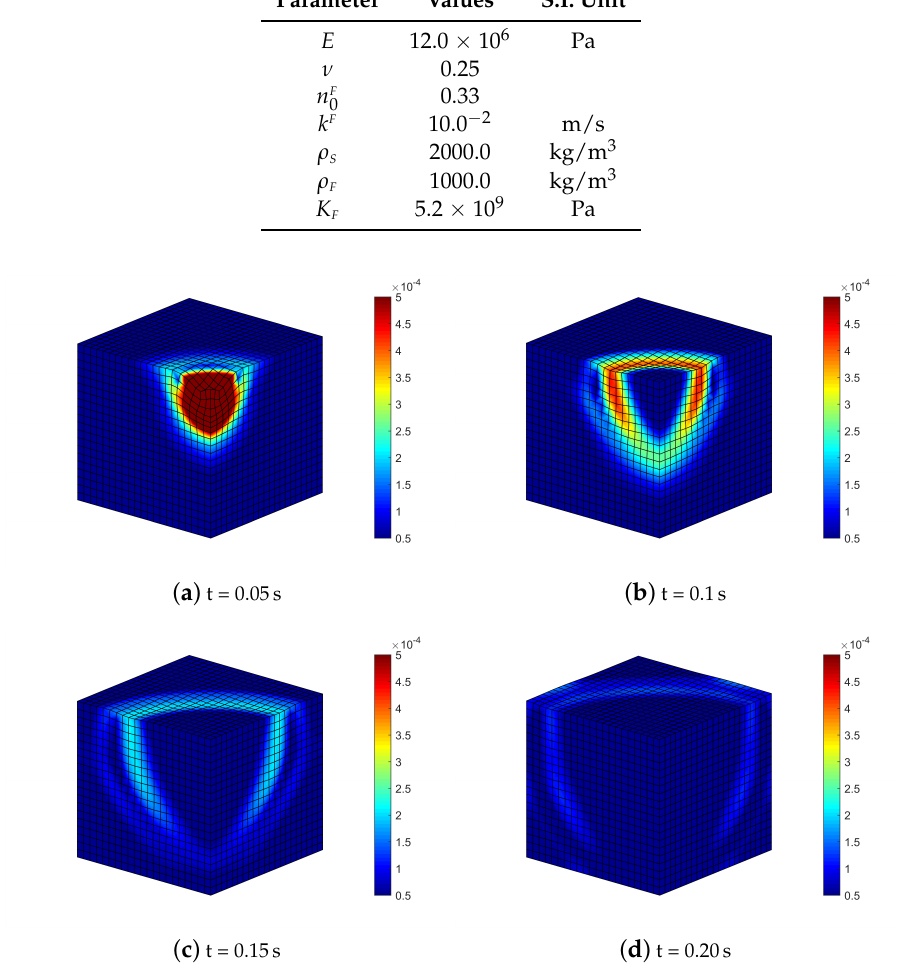
Figure 9. Isotropic soil model with K s = 5.210 7 Pa: deformed meshes (amplified by scale factor 500) and contours of norm of soil displacements vector